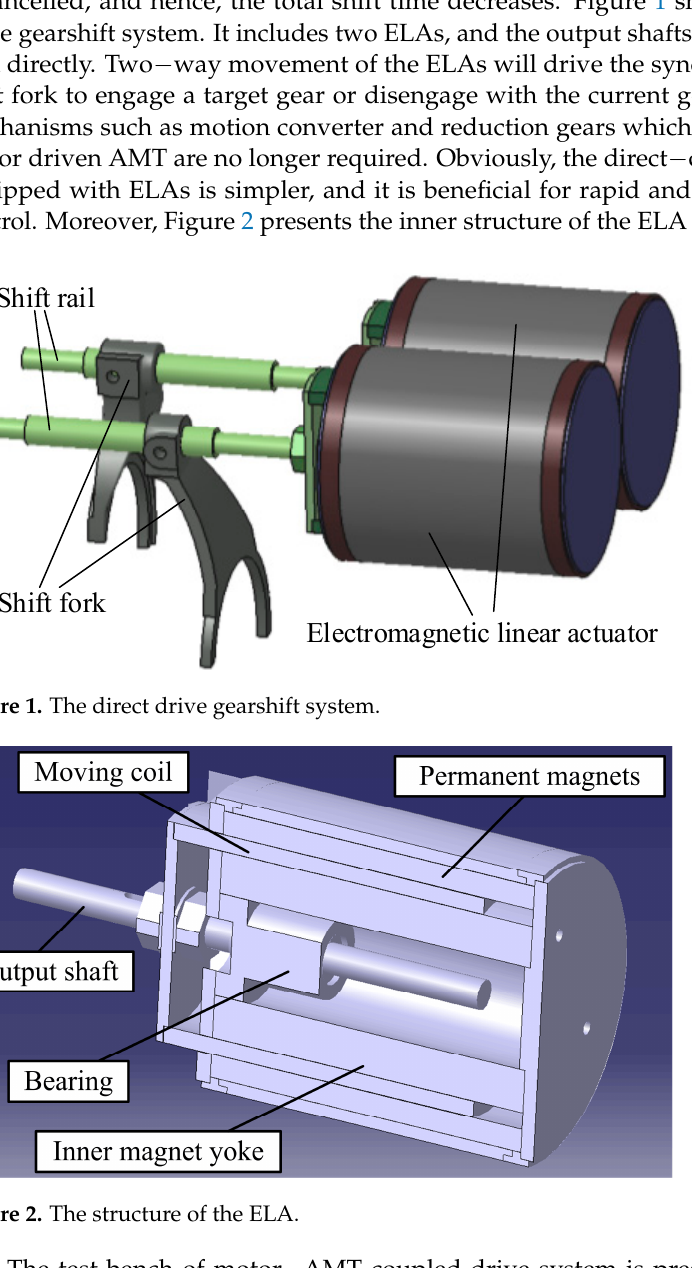
Figure 3. The test bench of motor-AMT coupled drive system. 3. Nonlinear Analysis and Modeling of Motor-AMT Coupled Drive System Nonlinearities exist in numerous complex and integrated systems. However, the nonlinear feature of the motor − AMT coupled drive system has not been studied exten- sively and comprehensively yet. The output characteristics are frequently nonlinear re- gardless of the kind of motor − induction motor or permanent magnet synchronous motor. ELAs should be taken into account while modeling the coupled system because they are a source of nonlinearities because of their operating theory and technology limitations. It is also important to study the nonlinearities that will manifest in an AMT’s gearings, shafts, and shift forks when enormous or rapidly fluctuating power is applied. Addition- ally, because the AMT shifting process is discrete, researchers have divided it into a num- ber of steps in order to develop various control strategies [30]. As a result, the nonlineari- ties might be produced during the switch of different control strategies and transferring of control parameters. 3.1. Nonlinear Analysis of the ELA Three subsystems − the electric, magnetic, and mechanical subsystems − can be used to characterize the ELA. Figure 4 displays the mathematical representation of ELA. Trans- fer lines are another way to show how the three subsystems are coupled. Obviously, the relationship between the input parameter voltage U and output parameter electromag- netic force F m is nonlinear.